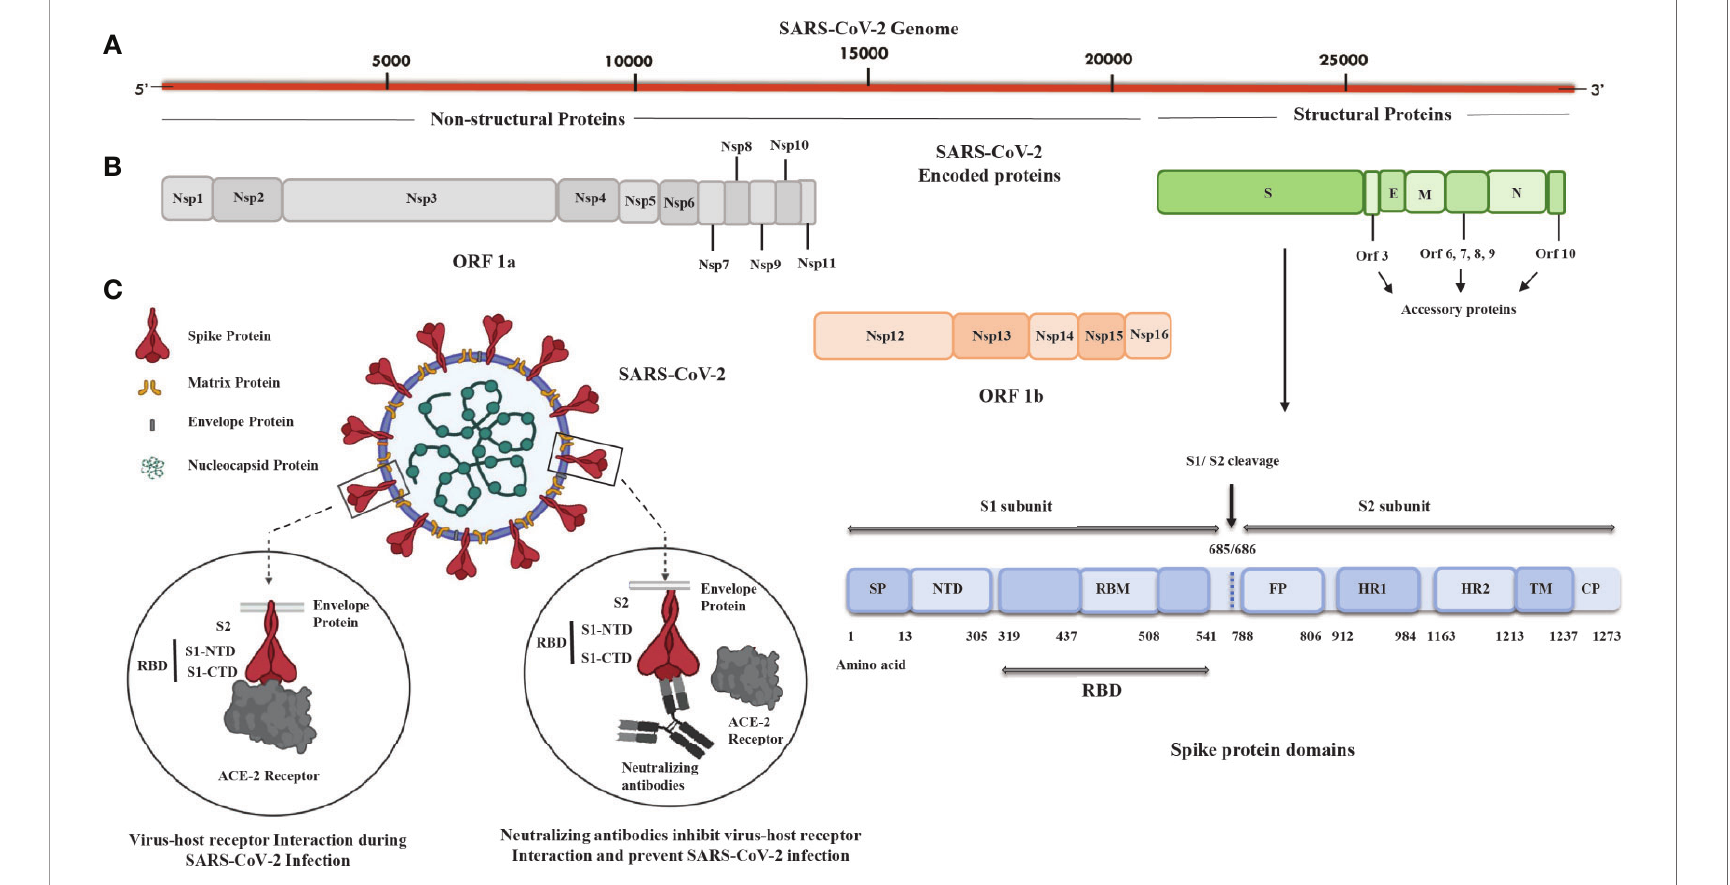
FIGURE 1 | SARS-CoV-2 genome, encoded proteins, and basic mechanism of virus fusion and entry. (A) Illustration of the SARS-CoV-2 genome that is around 30 kb in size and has a 5 ’ cap and 3 ’ poly A tail. (B) SARS-CoV-2 proteins: nonstructural proteins (Nsp), ORF1a, and ORF1b (Nsp1-Nsp16) and structural proteins such as spike (S), envelope (E), membrane (M), and nucleocapsid (N) with spike protein having 1273 aa (~180 kDa) containing signal peptide (SP), N-terminal domain (NTD), receptor binding motif (RBM) in receptor binding domain (RBD), fusion peptide (FP), heptad repeat (HR)-1, HR-2, transmembrane domain (TM), and cytoplasmic tail (CP) domains. There are accessory proteins Orf3; Orf6,7,8,9; and Orf10 located in between the S, E, M, and N proteins. (C) The spike protein subunit 1 (S1; aa 14-685) of SARS-CoV-2 consists of the RBD domain divided into two parts: S1 N-terminal domain (S1-NTD) and S1 C-terminal domain (S1-CTD) and spike protein subunit 2 (S2; aa 686-1273) containing TM and CP domains. S1-CTD interacts with the angiotensin-converting enzyme-2 (ACE-2) receptor of host cells and facilitates fusion and entry of virus. The neutralizing antibody against S1-CTD blocks the entry of the SARS-CoV-2 into host cells. ORF1a; Open reading frame 1a, ORF1b; Open reading frame 1b, aa; Amino